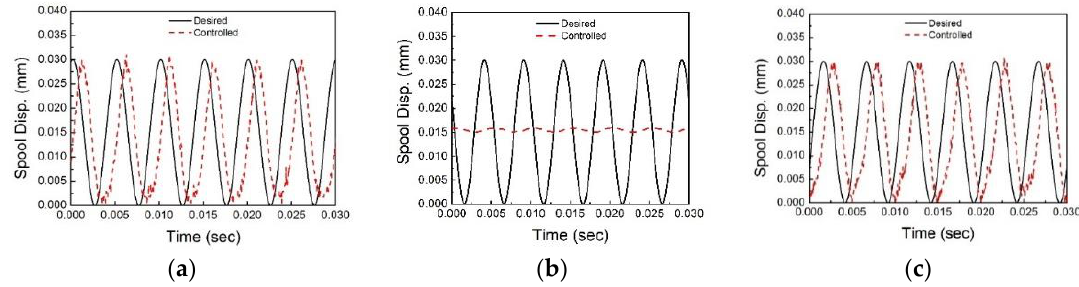
Figure 12. Tracking control results with 200 Hz, (a) Tracking control result via PID controller at 30 °C, (b) Tracking control result via PID controller at 150 °C with same PID gains at 30 °C, (c) Tracking control result via fuzzy PID controller at 150 °C .